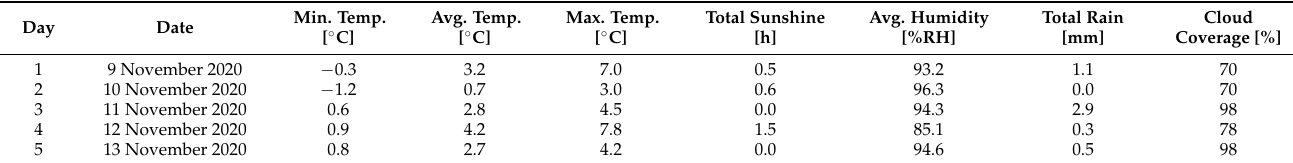
Table 2. Weather table for the 96 h experiment. Weather data is collected by [11] for the weather station “Saarbrücken- Ensheim” which is located ~11 km from the experiment site. Note the high average cloud coverage and low total sunshine per day.